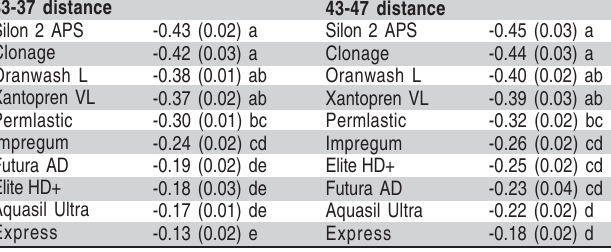
Means followed by different lowercase letters differ significantly